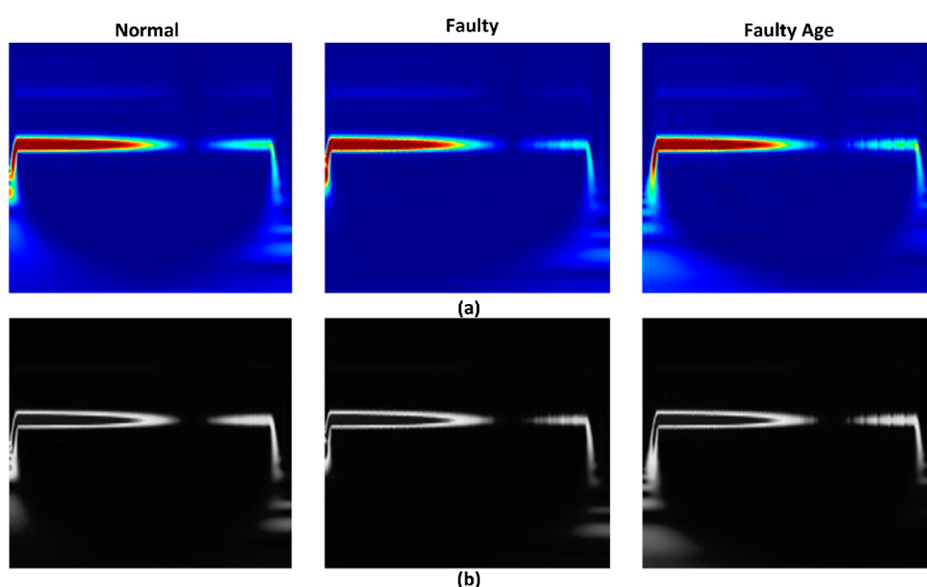
Figure 14. Scalogram images for multiple speed domains for a single cycle.